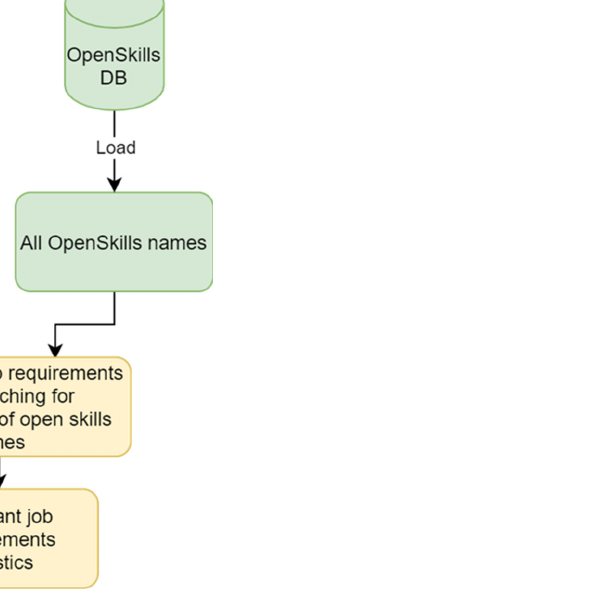
Figure 23. Visualization of the process of comparing the found job requirements with the Open Skills database. The results include the ratio of the found matches of the analyzed job requirements with Open Skills for individual job positions (see Table 8). Table 8. The ratio of the found relevant skills in Open Skills. Name of the Job Position Ratio of Relevant Skills in Open Skills linux administrator